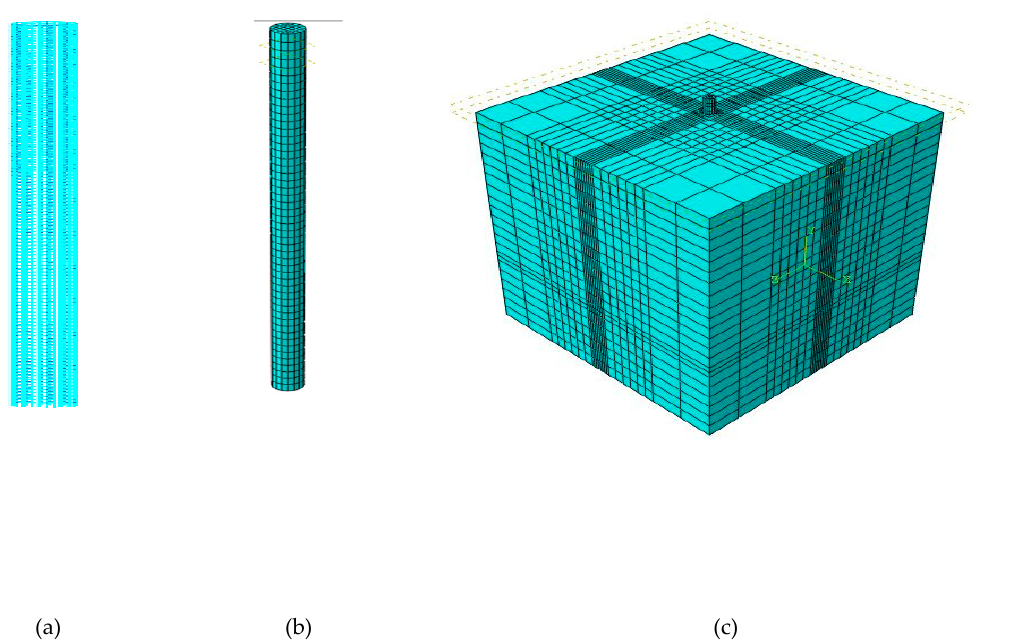
Figure 6. The meshing modeling of the soil pile ( a ) Steel bar; ( b ) Reinforcement Concrete Pile (RCP); ( c ) assembly with meshing.